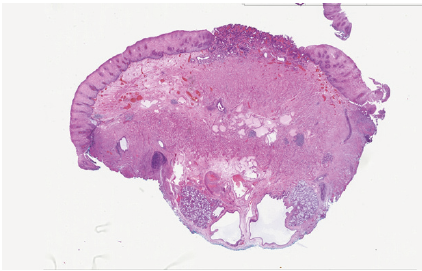
Figure 5: Low-magnification image showing focal high-grade dys- plasia on the surface with ectatic venous channels and heterotopic minor salivary gland tissue in the deeper aspect.